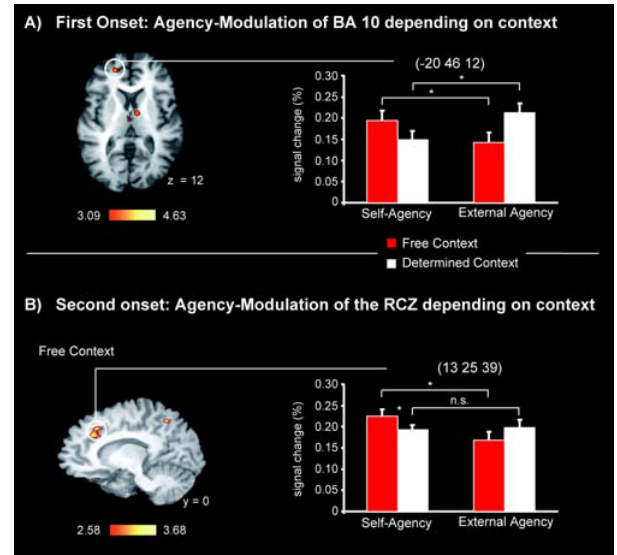
Figure 2. Activation maps averaged over 21 subjects mapped onto an individual brain. Red labels indicate positive z values. Coordinates are given in Talairach space. Error bars reflect standard errors. A) Activation elicited by the agency cues: Cross-over interaction between agency and context. Note that we also obtained a significant cross-over interaction in the mediodorsal nucleus of the thalamus (7, 2 5, 12). The activation in BA 10 comprised 107 contiguous voxels; the activation in the Thalamus comprised 103 contiguous voxels. B) Activation elicited by the task cues: Region of interest analysis in the rostral cingulate zone (RCZ) showing the main effect of agency (self- agency . external agency) only in free-context trials. The activation in the RCZ comprised 91 contiguous